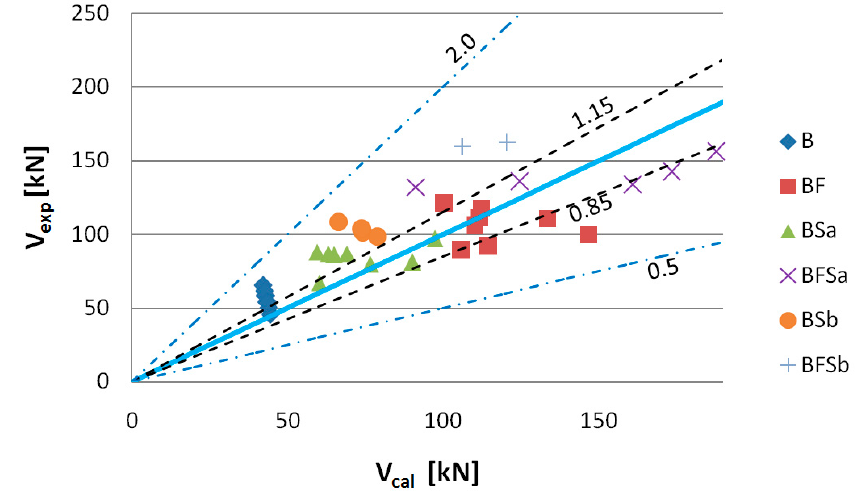
Figure 25. Values of experimentally fixed ( V exp ) versus computational ( V cal ) shear capacity deter- mined according to the former Model Code 2010 SMCFT method (measured angle θ ).